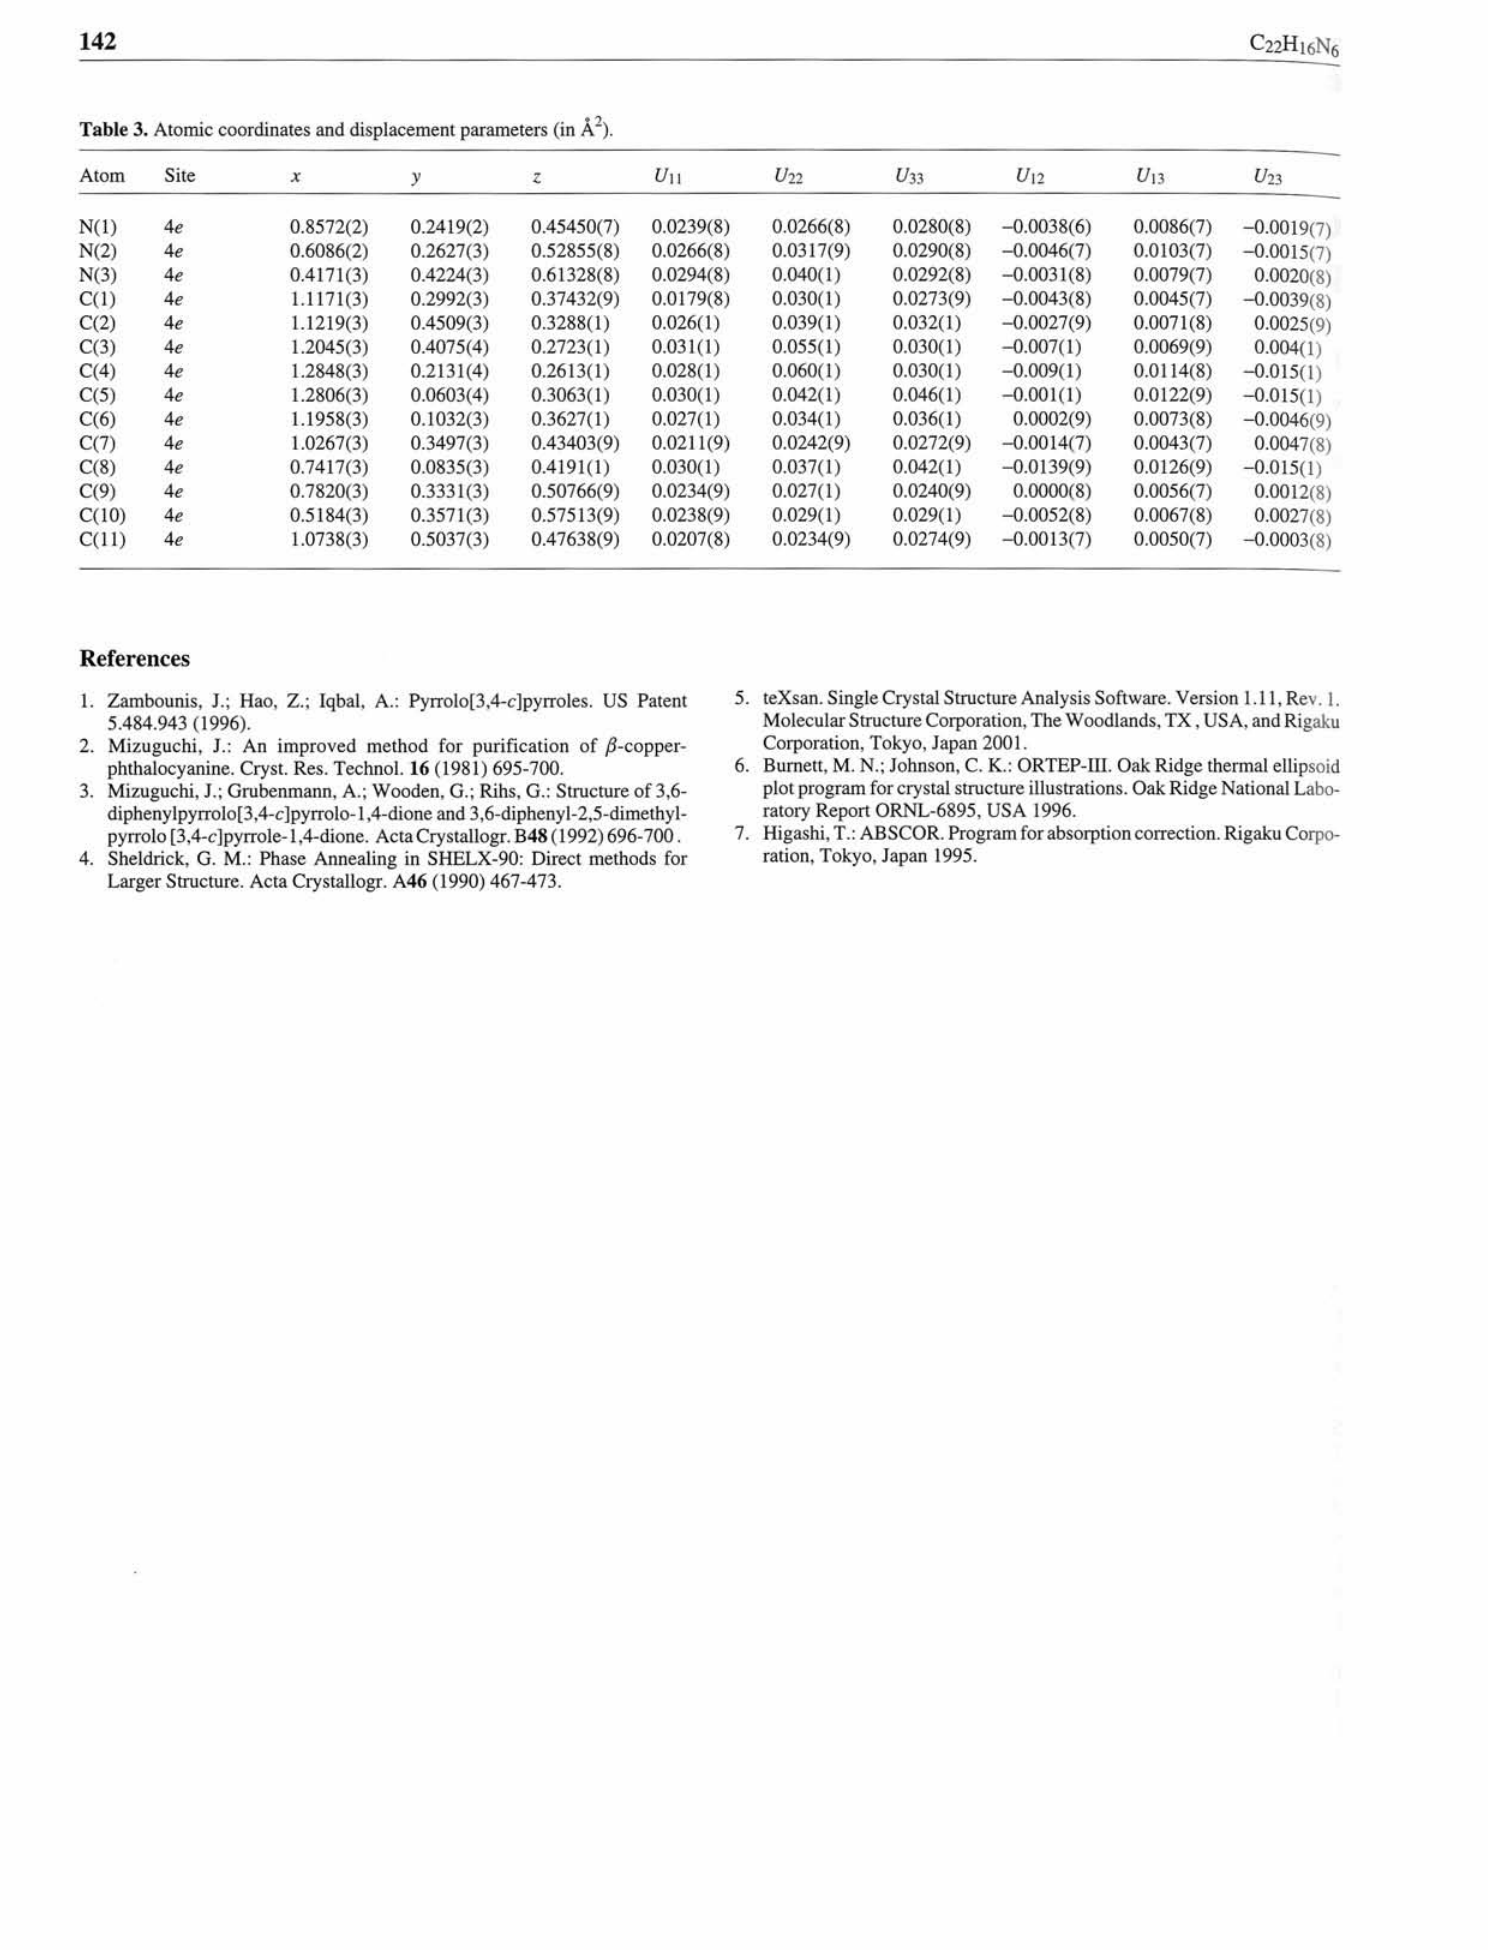
Table 3. Atomic coordinates and displacement parameters (in Â 2